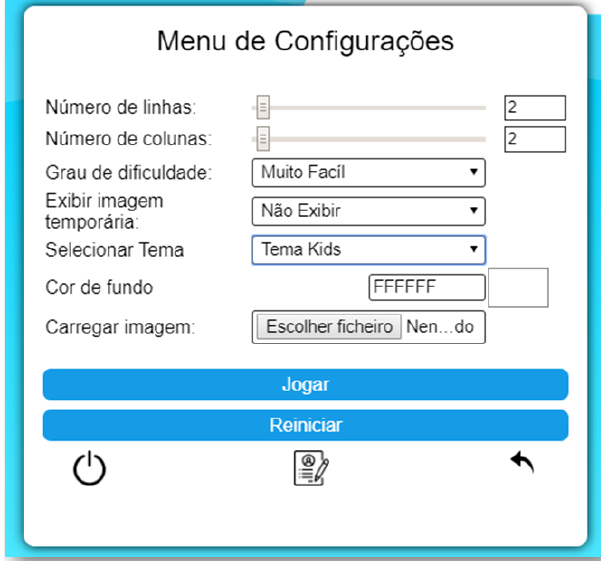
Figure 7. AdaptaQuebra­Cabeça’s configuration menu